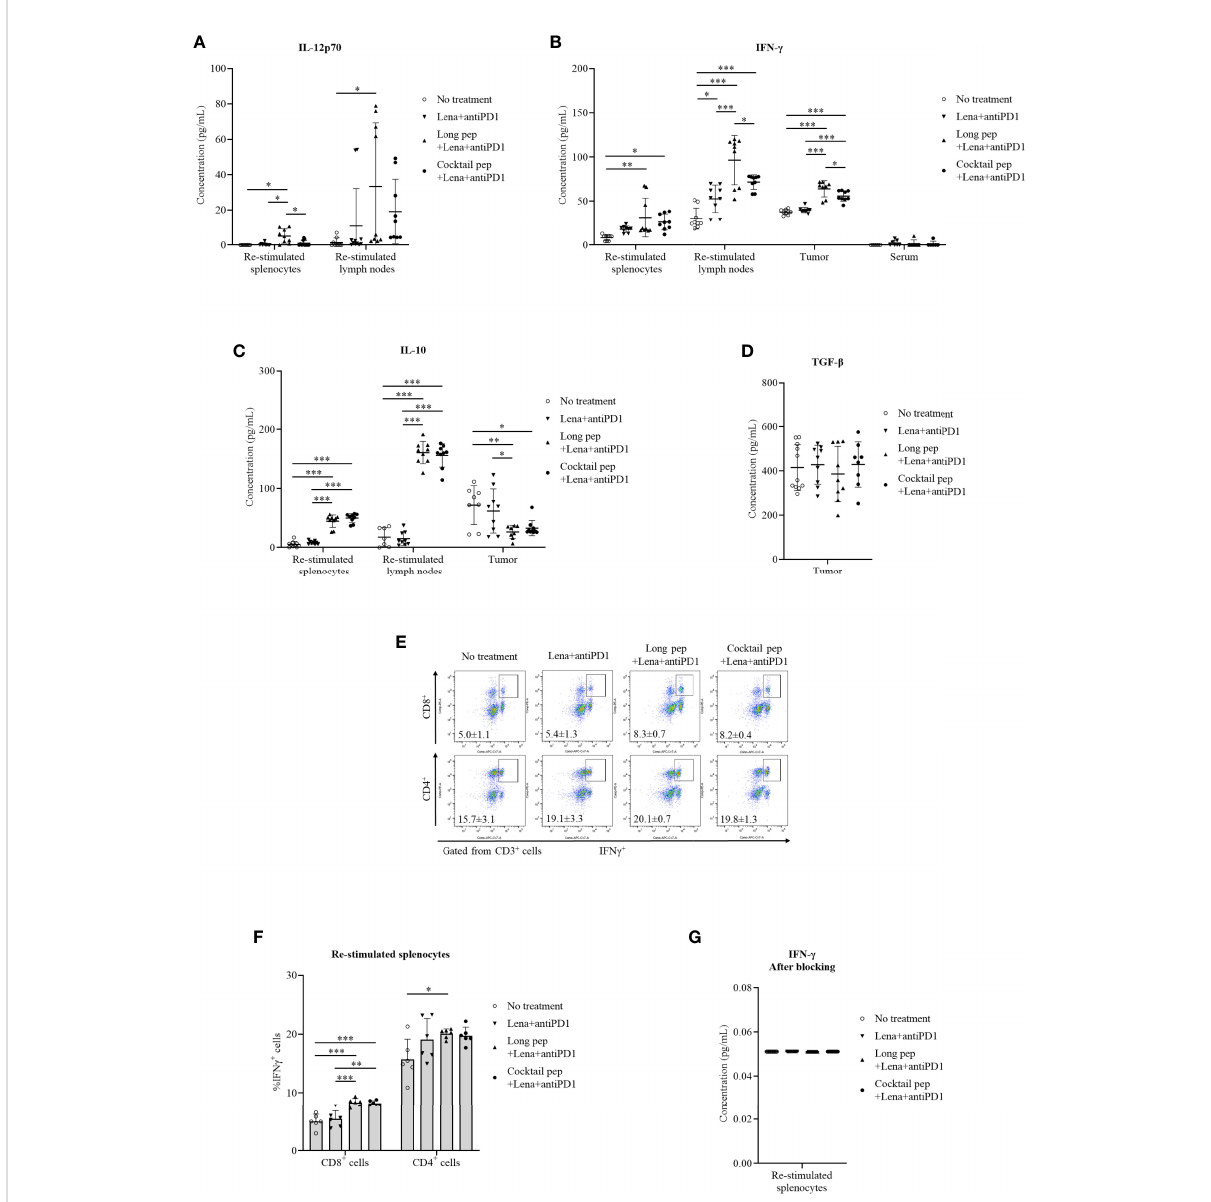
FIGURE 4 The pro-in fl ammatory and anti-in fl ammatory cytokine production in the culture media of re-stimulated splenocytes, re-stimulated lymph nodes, single tumor cells, and serum was determined via an ELISA. The released pro-in fl ammatory cytokines IL-12p70 were determined in the culture media of re-stimulated splenocytes and re-stimulated lymph nodes (No treatment: n = 9 and n = 9, Lena+anti-PD1: n = 9 and n = 7, long pep+Lena+anti-PD1: n = 9 and n = 9, and cocktail pep+Lena+anti-PD1: n = 7 and n = 9, respectively), IFN- g were determined in the culture media of re-stimulated splenocytes, re-stimulated lymph nodes, single tumor cells, and serum (No treatment: n = 9, n = 9, n = 9, and n = 6, Lena+anti-PD1: n = 9, n = 9, n = 9, and n = 7, long pep+Lena+anti-PD1: n = 9, n = 9, n = 8, and n = 6, and cocktail pep+Lena+anti-PD1: n = 9, n = 9, n = 9, and n = 6, respectively) (A, B) . The anti-in fl ammatory cytokine (IL-10) levels were determined in the culture media of re- stimulated splenocytes, re-stimulated lymph nodes, and single tumor cells (No treatment: n = 10, n = 7 and n = 8, Lena+anti-PD1: n = 9, n = 9 and n = 9, long pep+Lena+anti-PD1: n = 9, n = 9 and n = 8, and cocktail pep+Lena+anti-PD1: n = 9, n = 9 and n = 10, respectively), TGF- b were determined in the culture media of single tumor cells (No treatment: n = 11, Lena+anti-PD1: n = 9, long pep+Lena+anti-PD1: n = 9, and cocktail pep+Lena+anti-PD1: n = 8, respectively), (C, D) . The percentages of CD8 + IFN- g + cells and CD4 + IFN- g + cells in the re-stimulated splenocytes and IFN- g levels in the supernatant after membrane blocking for IFN- g intracellular staining were calculated after 24 hours of re- stimulation (n = 6 mice per group) (E-G) . All data is shown as the mean ± standard deviation (SD). No treatment: no treatment group; Long pep: long multi-epitope peptide; Long pep+Lena: long multi-epitope peptide plus lenalidomide; Lena+anti-PD1: Lenalidomide plus anti-PD1; Long pep+Lena+anti-PD1: long multi-epitope peptide plus lenalidomide and anti-PD1; Cocktail pep+Lena+anti-PD1: cocktail of multi-epitope peptide plus lenalidomide and anti-PD1. p< 0.05 (*), p< 0.001 (**), p< 0.0001